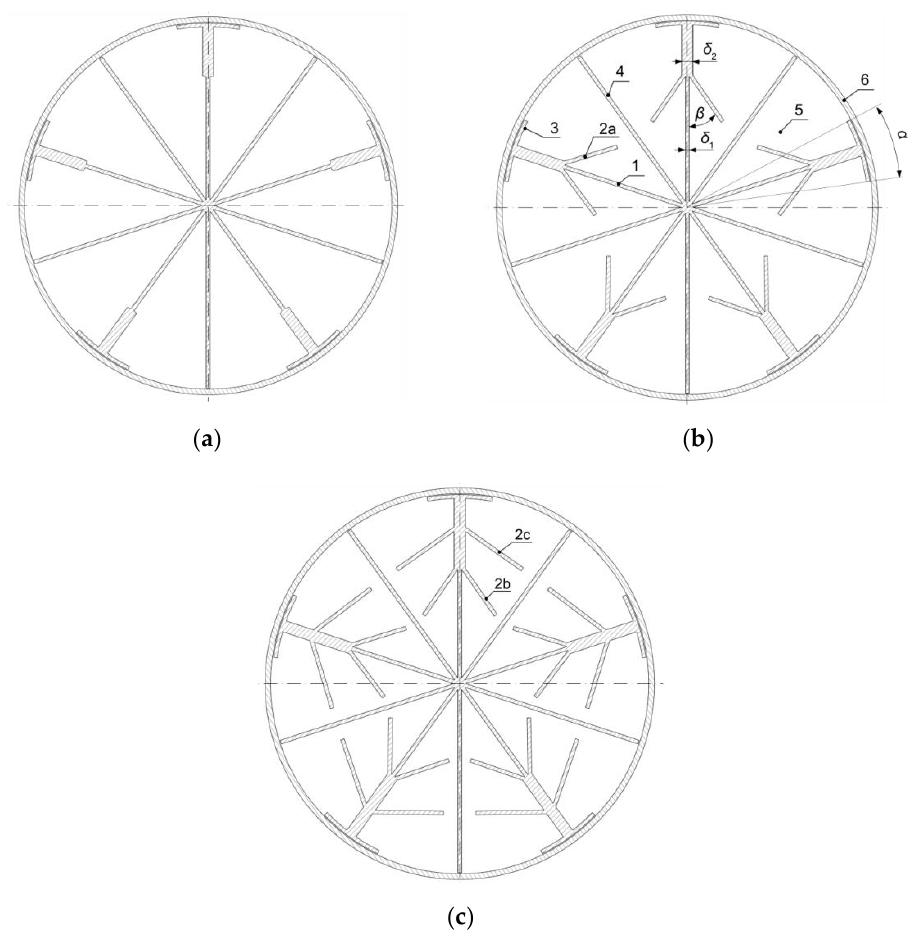
Figure 4. Intensifier geometries: ( a ) Geometry 2; ( b ) Geometry 3; ( c ) Geometry 4.